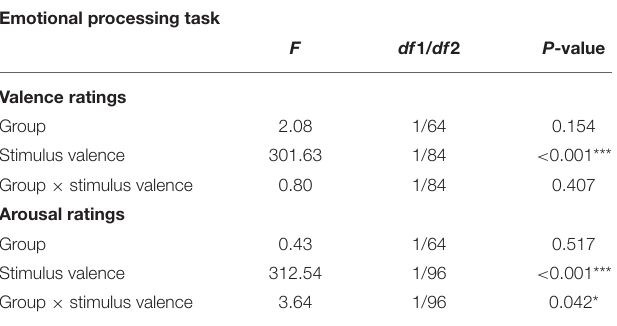
TABLE 4 | Results of the analyses of variance for mean valence and arousal ratings with between-subject factor “group” (IBD/HC) and within-subjects factor “stimulus valence”